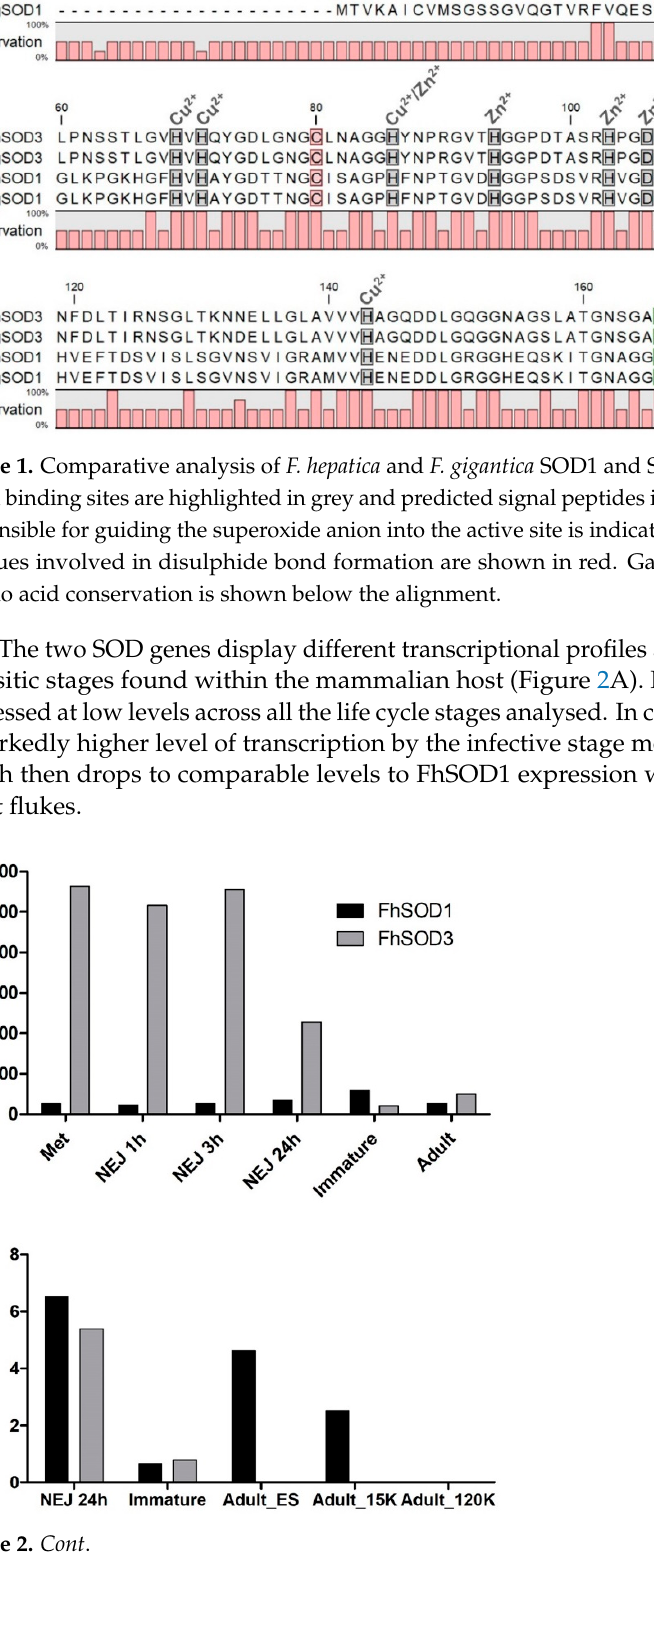
Figure 2. Expression profile of FhSOD1 and FhSOD3 throughout the F. hepatica life cycle within the mammalian host. ( A ) Graphical representation of the stage-specific transcription of the FhSOD1 and FhSOD3 genes displayed as transcripts per million (TPM) extrapolated from the transcriptome study of the metacercariae (Met), newly excysted juveniles at 1, 3, and 24 h post-excystment (NEJ 1 h, NEJ 3 h, NEJ 24 h), immature and adult liver flukes by Cwiklinski et al. [5]. ( B ) Graphical repre- sentation of the FhSOD1 and FhSOD3 proteins secreted within the ES protein fraction by the NEJ, immature, and adult parasites, represented by the exponentially modified protein abundance index (emPAI). The adult secretome data are displayed as the EV-depleted fraction (Adult_ES), and the microvesicle (Adult_15K) and exosome (Adult_120K) sub-fractions of the EV component recovered following centrifugation at 15,000× g and 120,000× g , respectively. ( C ) Graphical representation of the FhSOD1 and FhSOD3 protein abundance within the somatic proteome of the metacercariae (Met); newly excysted juvenile (NEJ) 3, 24, and 48 h post-excystment (NEJ 3 h; NEJ 24 h; NEJ 48 h); and immature liver flukes. The proteomic data for the NEJ, immature, and adult parasites are ex- trapolated from Cwiklinski et al. [6], Cwiklinski et al. [7], and Murphy et al. [30], respectively. Despite the relatively lower level of gene transcription, proteomic analysis revealed that FhSOD1 is more abundantly secreted than its extracellular counterpart, FhSOD3, pre- dominantly by the NEJ and adult parasite stages (Figure 2B). Analysis of the adult secre- tome revealed that, in addition to being secreted within the protein soluble fraction, FhSOD1 is also found within extracellular vesicles (EVs), specifically the microvesicles that are known to be released by the gastrodermal cells of the gut. This is consistent with other F. hepatica proteins that lack a signal peptide sequence for classical secretion, high-